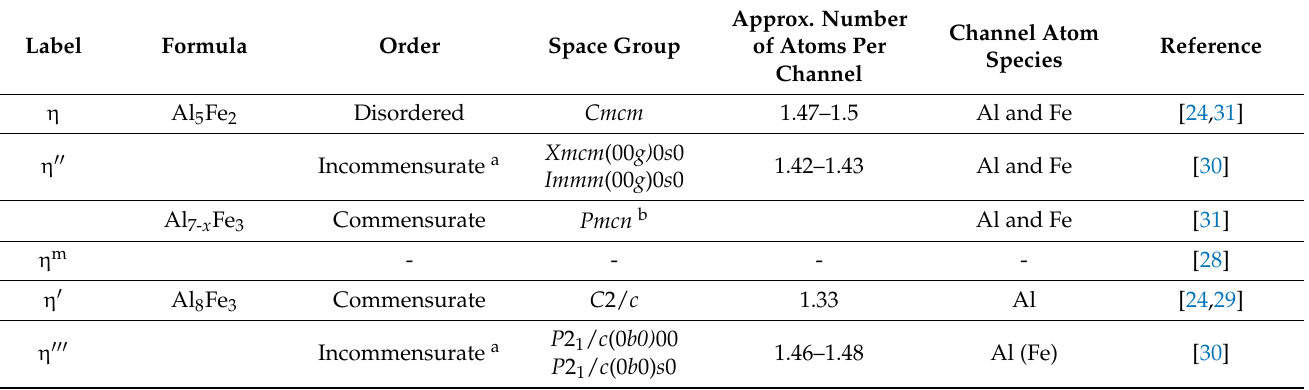
Table 1. Ordered and disordered phases of the Al 5 Fe 2 field in the Al–Fe system. Whereas the disordered η (cid:48) phase appears to exist over the range of 70.6 at% to 73.0 at% Al [30], the commensurately or incommensurately ordered phases appear to occur in narrower ranges of composition in the sequence as listed from low to high Al content ( η (cid:48)(cid:48) , η m , η (cid:48) , η (cid:48)(cid:48)(cid:48) ).